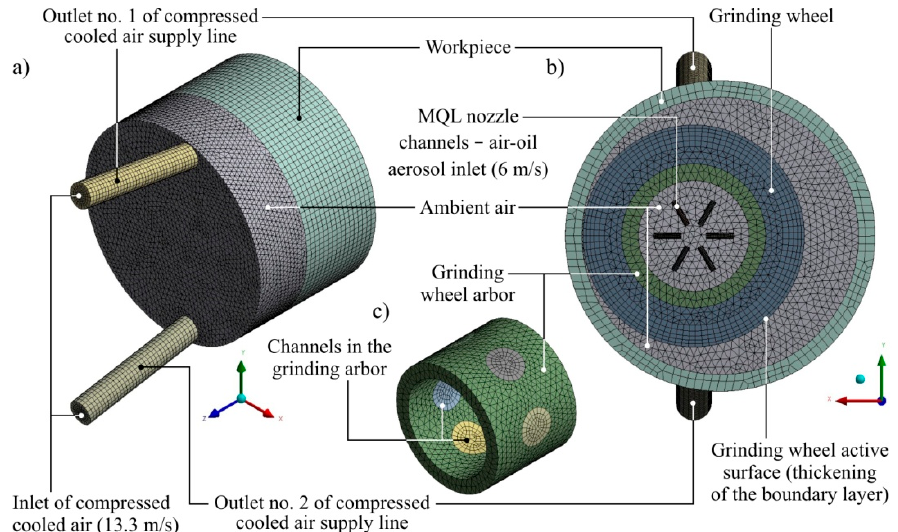
Figure 3. View of the simulation model solids after discretisation: ( a ) isometric view of all elements of the model; ( b ) view of all elements of the model in the xy plane; ( c ) isometric view of the grinding arbor model.